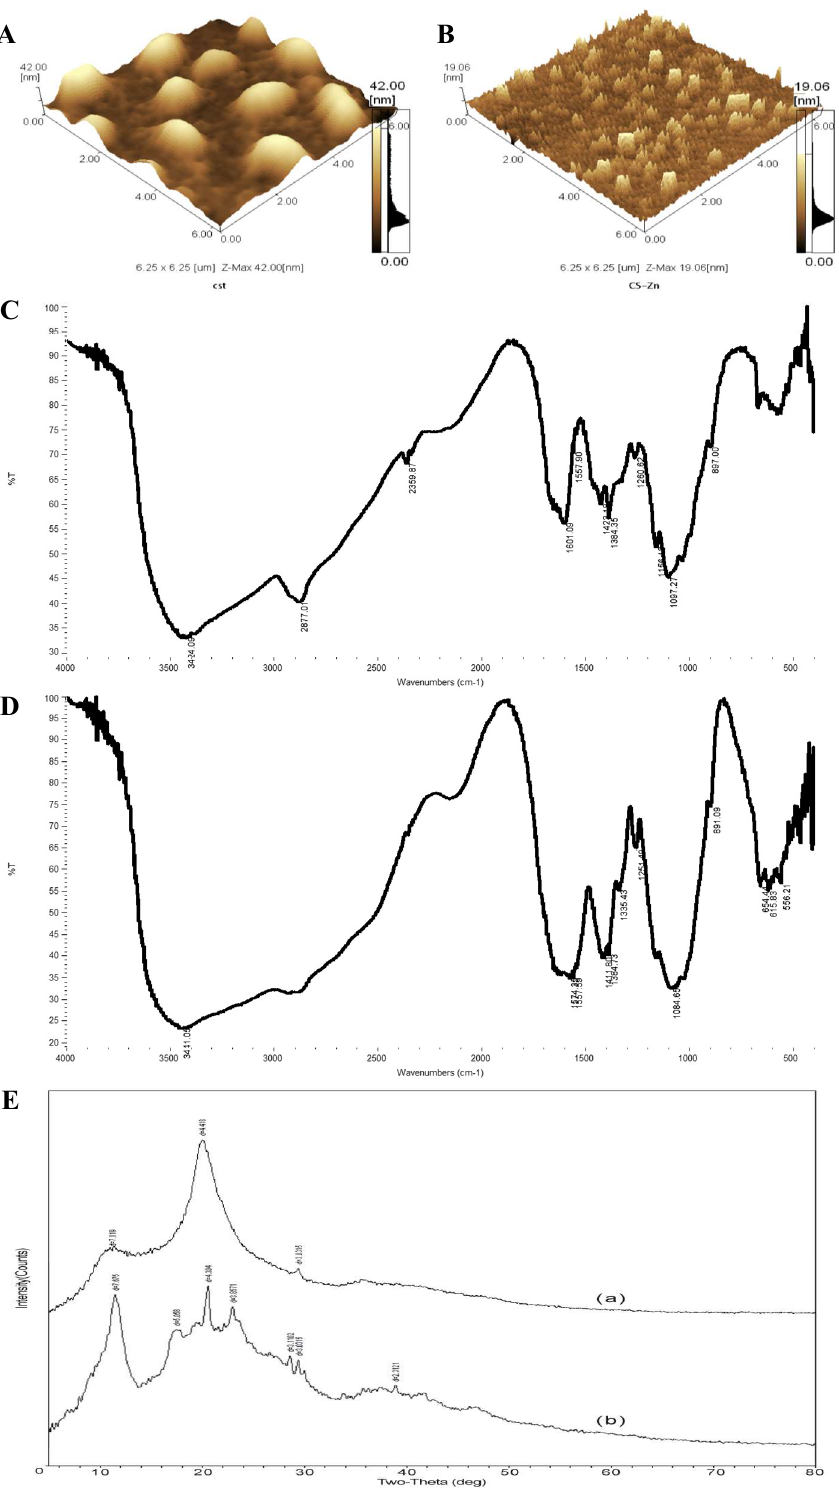
Figure 1. ( A ) AFM images of chitosan. ( B ) AFM images of chitosan–zinc chelate. ( C ) FT-IR spectrum of chitosan. ( D ) FT-IR spectrum of chitosan–zinc chelate. ( E ) X-ray diffractogram of (a) chitosan, (b) chitosan–zinc chelate.